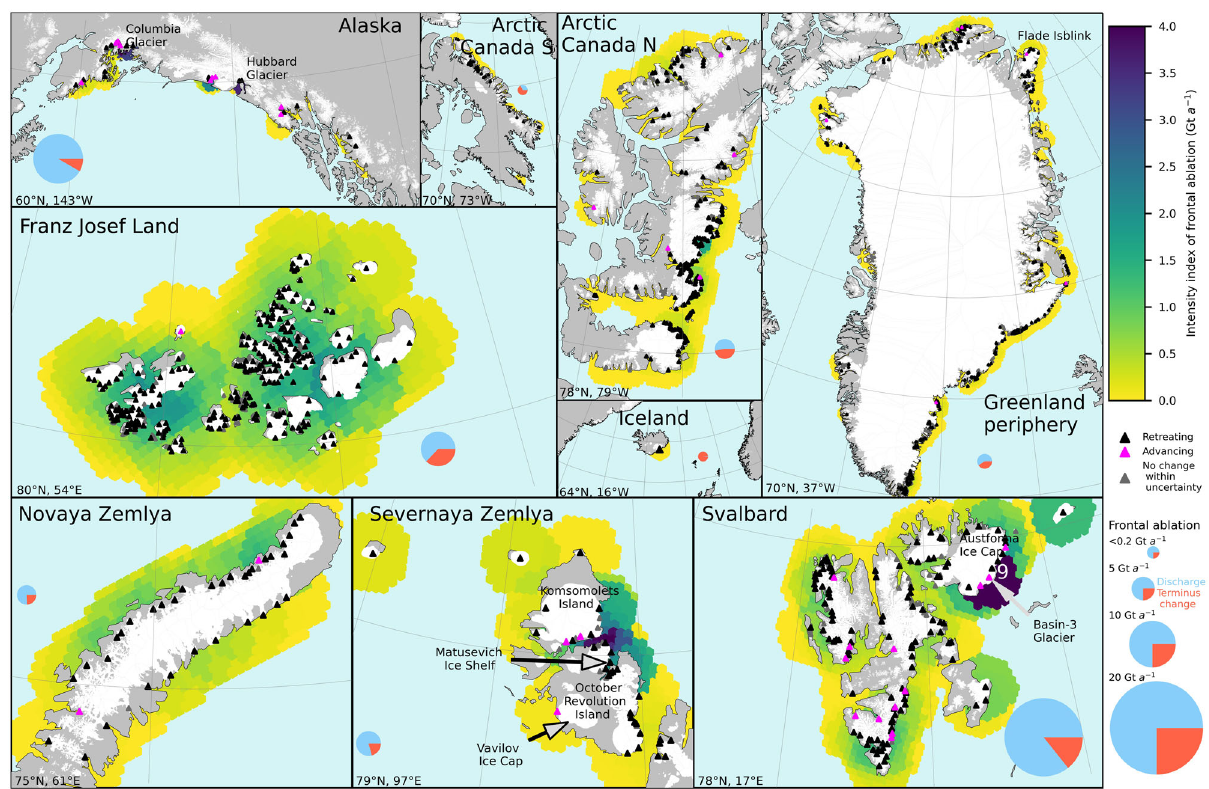
Fig. 3 | Intensity index of frontal ablation in near-coastal ocean environments 2010 – 2020. The index is de fi ned as the sum of the frontal ablation rates of all glacierswithin 50kmof theirterminus, basedon a 10kmocean grid. Textinwhite indicates values outside the color scale. The pie charts show the proportion of ice discharge(blue)andterminuschange(red)tototalfrontalablationforeachregion,